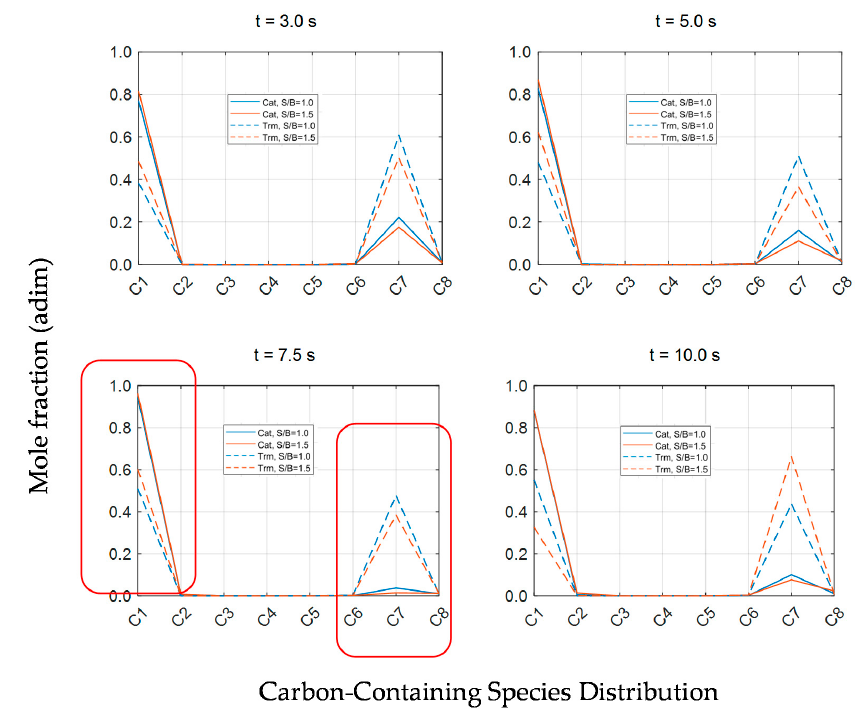
Figure 12. Carbon-containing species distribution for catalytic and thermal runs in the CREC riser simulator at S / B = 1.0 and 1.5, at a 500 ◦ C temperature, and at four reaction times: 3 s, 5 s, 7.5 s, and 10 s. simulator at S/B = 1.0 and 1.5, at a 500 °C temperature, and at four reaction times: 3 s, 5 s, 7.5 s, and 10 s. Note: the red rectangles highlight the C1–C2 and C6–C8 fractions. Note: the red rectangles highlight the C1–C2 and C6–C8